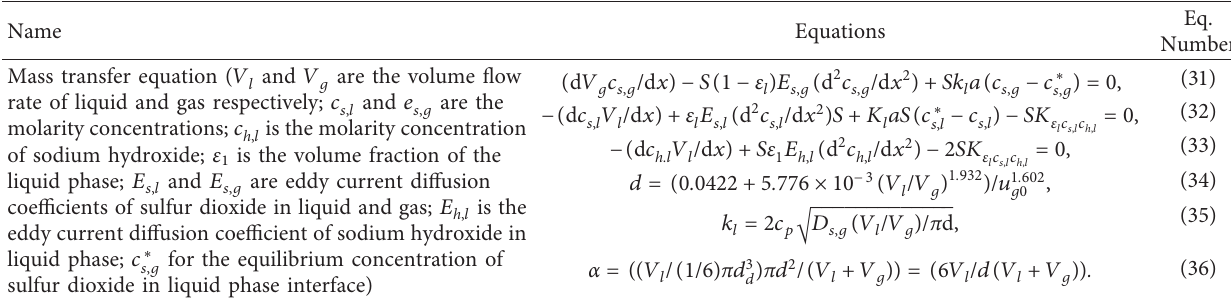
Table 2: The equations for mass